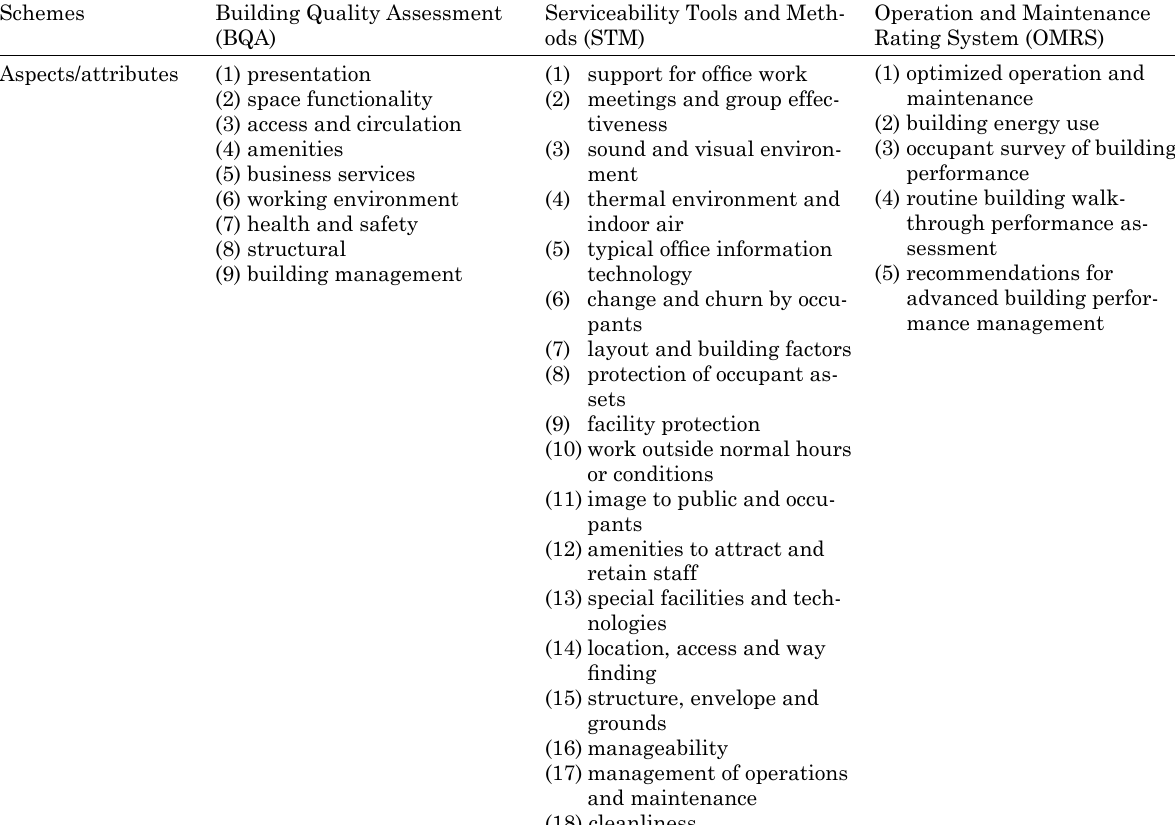
Table 1. Key elements of selected evaluation schemes